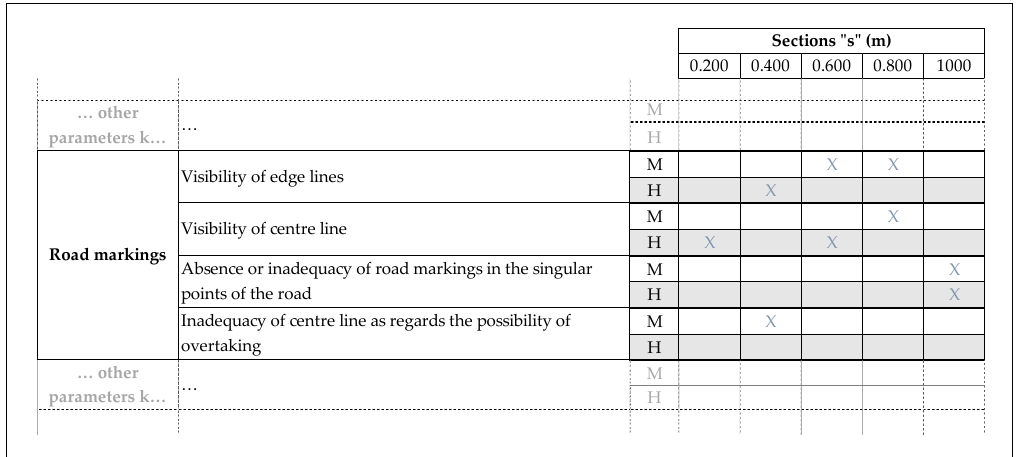
Figure 4. Excerpt from an inspection report. Example of the assessment of the safety performance (SP) value for the ith kilometer (rural area). For this scenario from the output of inspection, for only the parameter “road markings”, the value of SP RM is 6.5 (where M = medium severity and H = high severity).